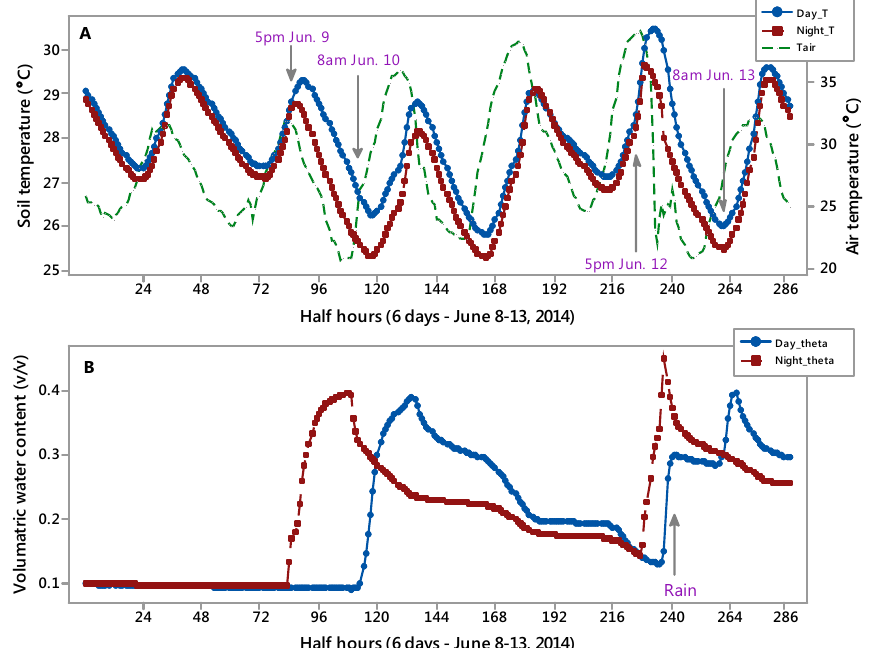
Figure 2. Soil temperature (connected symbols), air temperature (dashed line) (panel A ) and soil water content (panel B ) measured at 10 cm depth over 6 days from 8–13 June 2014, in both day-time and night-time irrigated plots (each data point is the average of three CS-655 soil sensors buried at 10 cm depth along rows of the drip-irrigated corn plants). Arrows in (panel A) show the times the drip irrigation was applied during 8–13 June 2014.